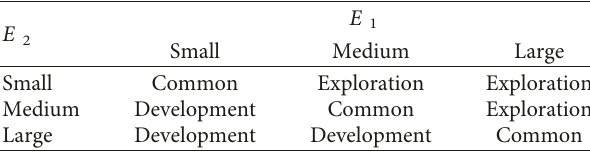
Table 1: Rule of fuzzy evolutionary strategy.